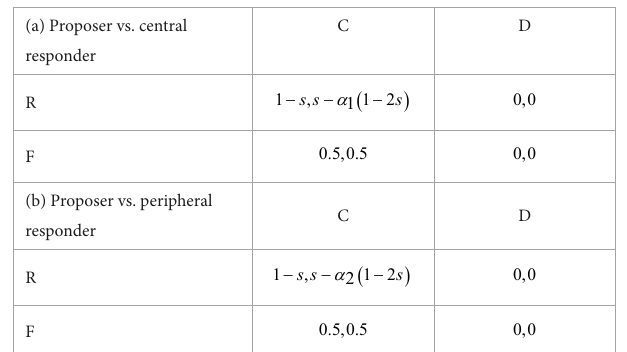
TABLE 1 Utility matrix between proposer and